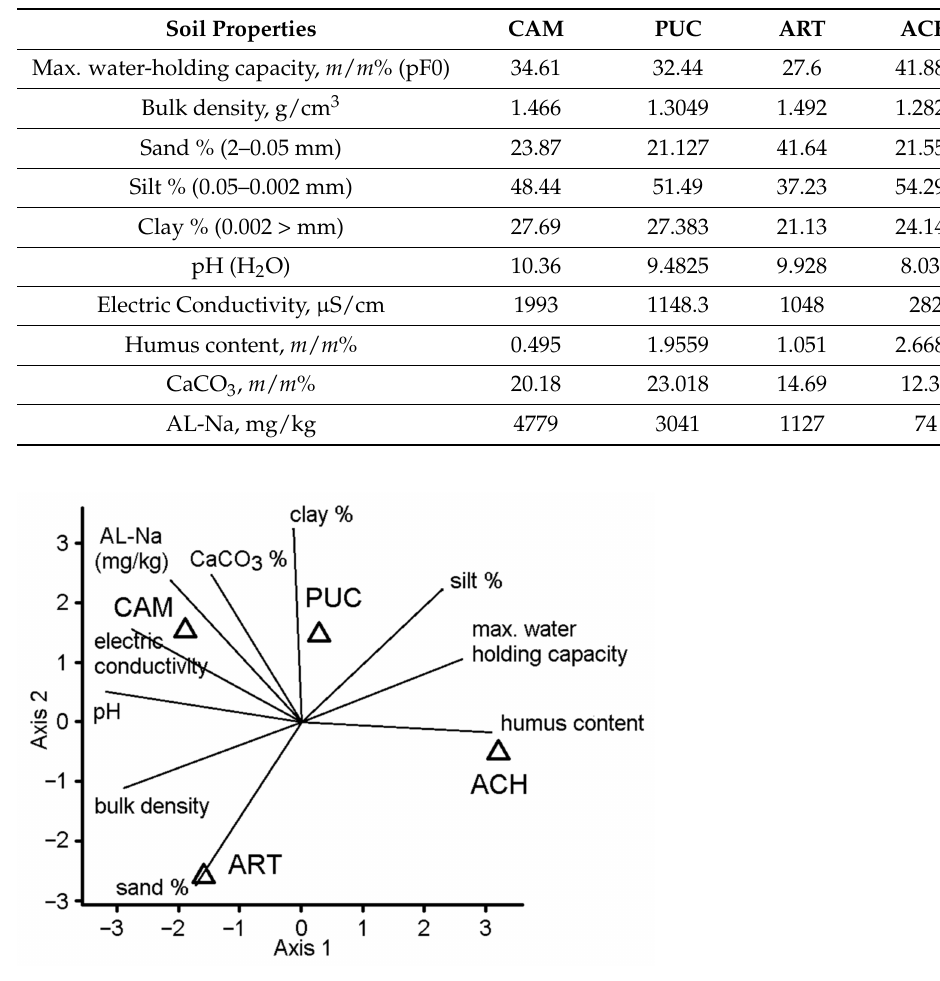
Figure 4. PCA ordination diagram according to ten soil variables for the four characteristic habitats in the salt-affected landscape of Apajpuszta, Hungary. CAM = annual open salt sward, PUC = Pannonic Puccinellia limosa hollow, ART = Artemisia saline puszta, ACH = grassy saline puszta. For a detailed description of soil variables, see the text in the Materials and Methods